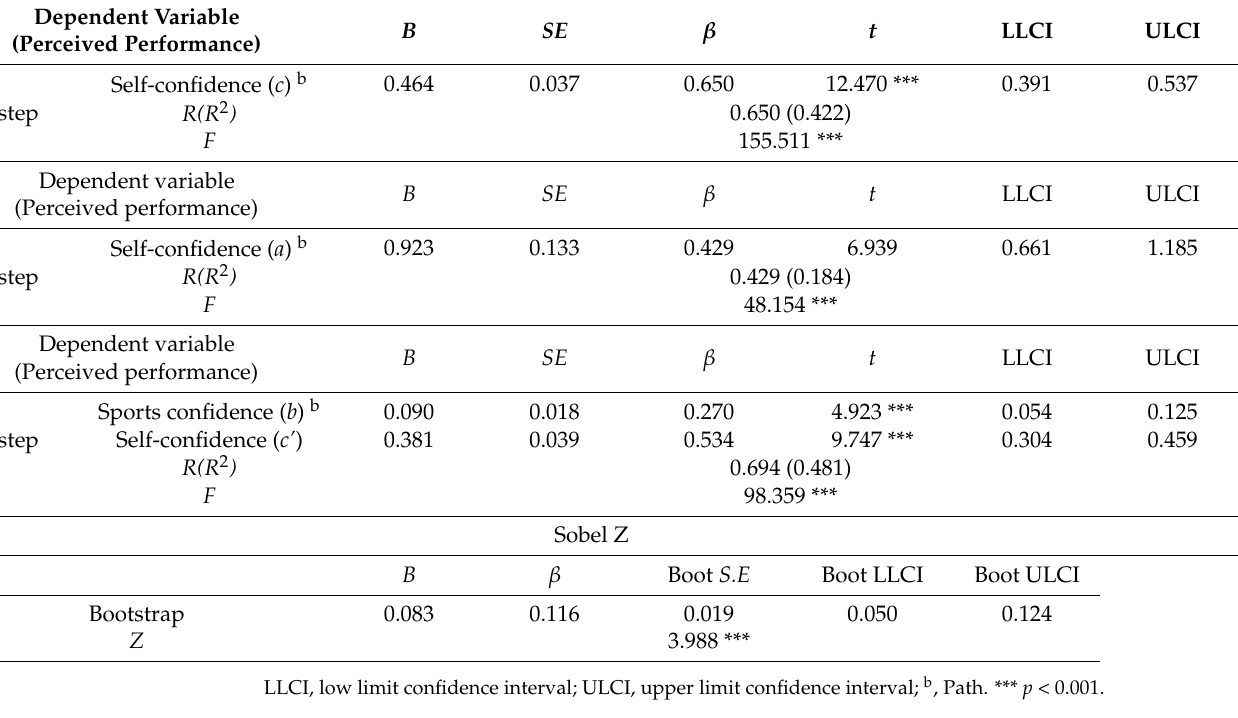
Table 8. Analysis of the mediating effect of sports confidence on the relationship between self- confidence and perceived performance ( n = 215).